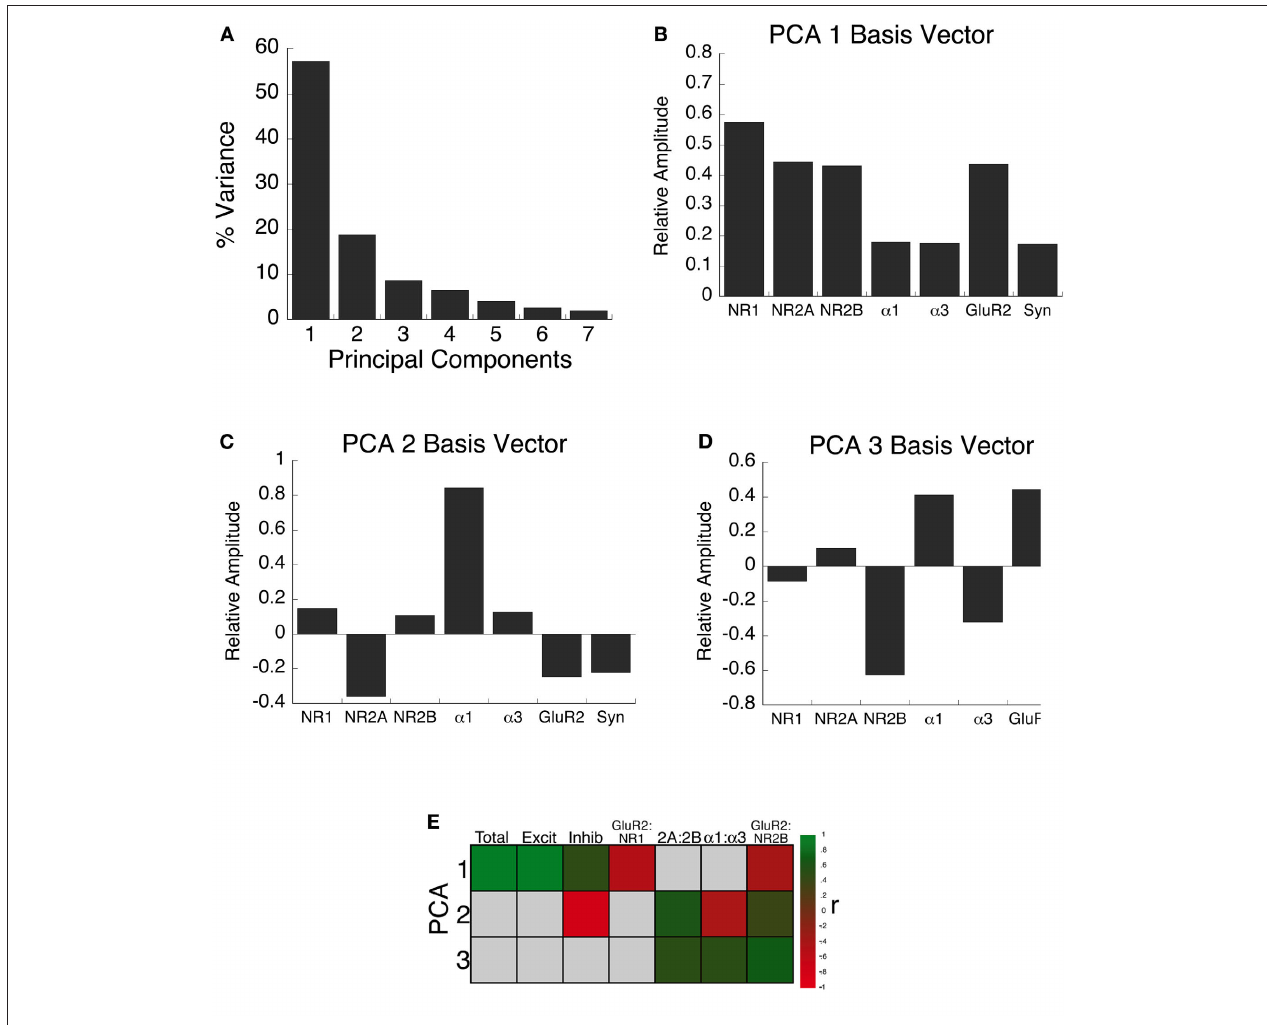
FiGure 9 | Principal component analysis. (A) The percent of variance captured by each component from SVD analysis of receptor subunit expression in visual cortex of normal and monocularly deprived kittens. The first three principal components represent the significant portion (85%) of the SVD. (B–D) The influence of each subunit on the three principal components was reflected by the